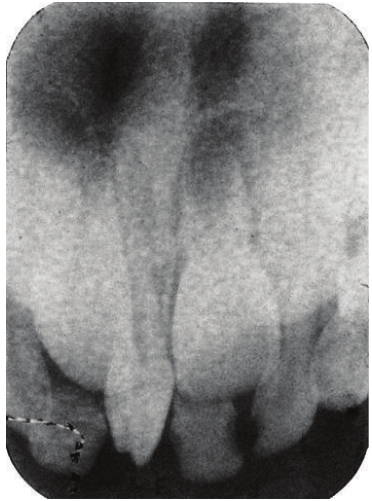
Figure 2: IOPA radiograph showing multilobulated mesiodens between maxillary primary central incisors.